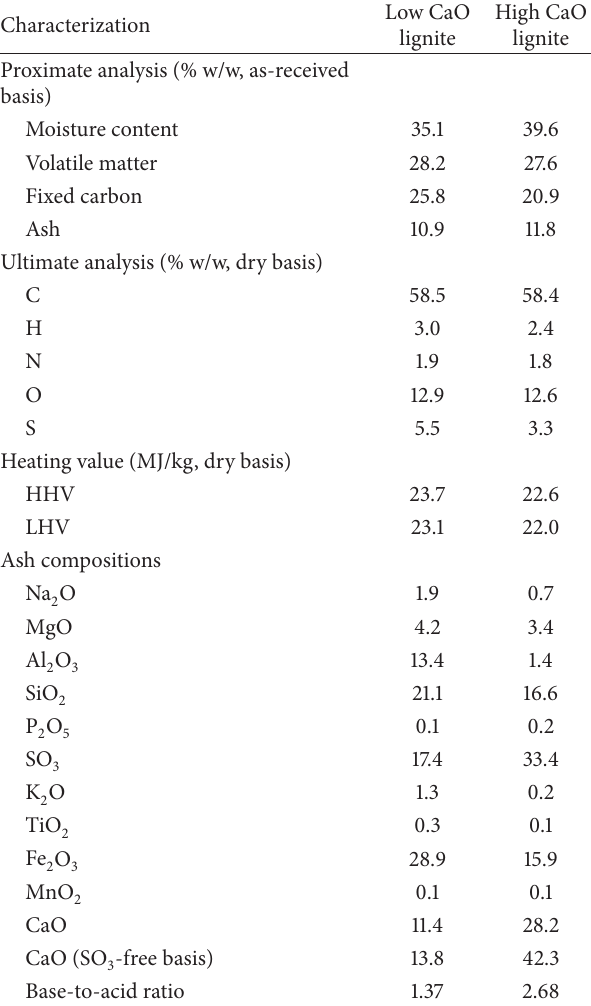
Table 1: Analysis results of Thai lignite samples.